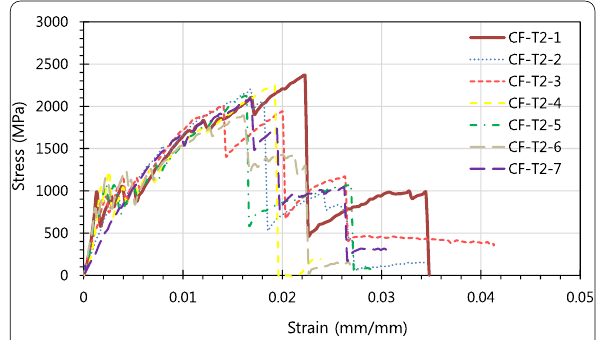
Fig. 9 Tensile test results: C-FRCM with two layers of fabric.